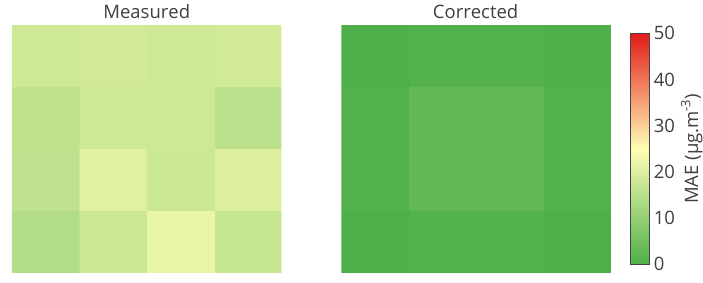
Figure 10. Matrix of the MAE, computed on the entire time interval of drift, of the 16 nodes of the network without calibration and with SM-SVD. It shows exactly the information for each instrument. The colour scale can help to identify problematic instruments.